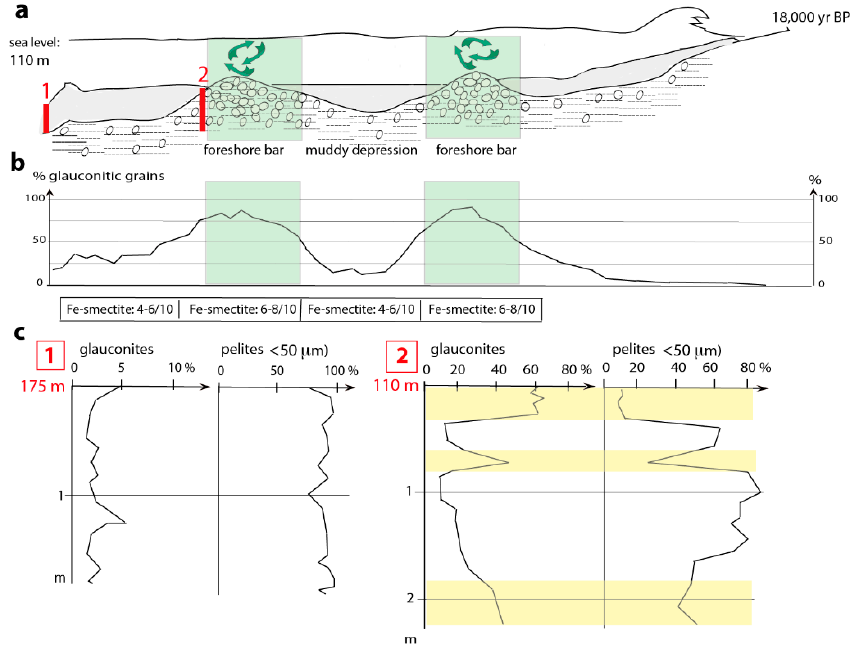
Figure 12. ( a , b ) Simplified diagram of the deposition and levigation processes of glauconitic sand barriers around 18,000 years BP on the Gulf-of-Guinea shelf, with locations of sediment cores 1 and 2 at depths of 175 and 110 m, respectively; ( c ) 1. at − 175 m, from a distance of the 18,000-years-BP shoreline, the glauconitic accumulation is low and regular; the glauconitization process is more advanced towards the top of the deposit (end of the Holocene). 2. Alternation of deposits with high (pale-yellow bands) and low energies at − 110 m during the 18,000-years-BP regression; green grains are the best crystallized and concentrated in the sediment. Alternation of deposits with high and low energies at − 110 m during the 18,000-years-BP regression; the green grains are the best-crystallized as they are numerous in the sediment (partly after [27,28]